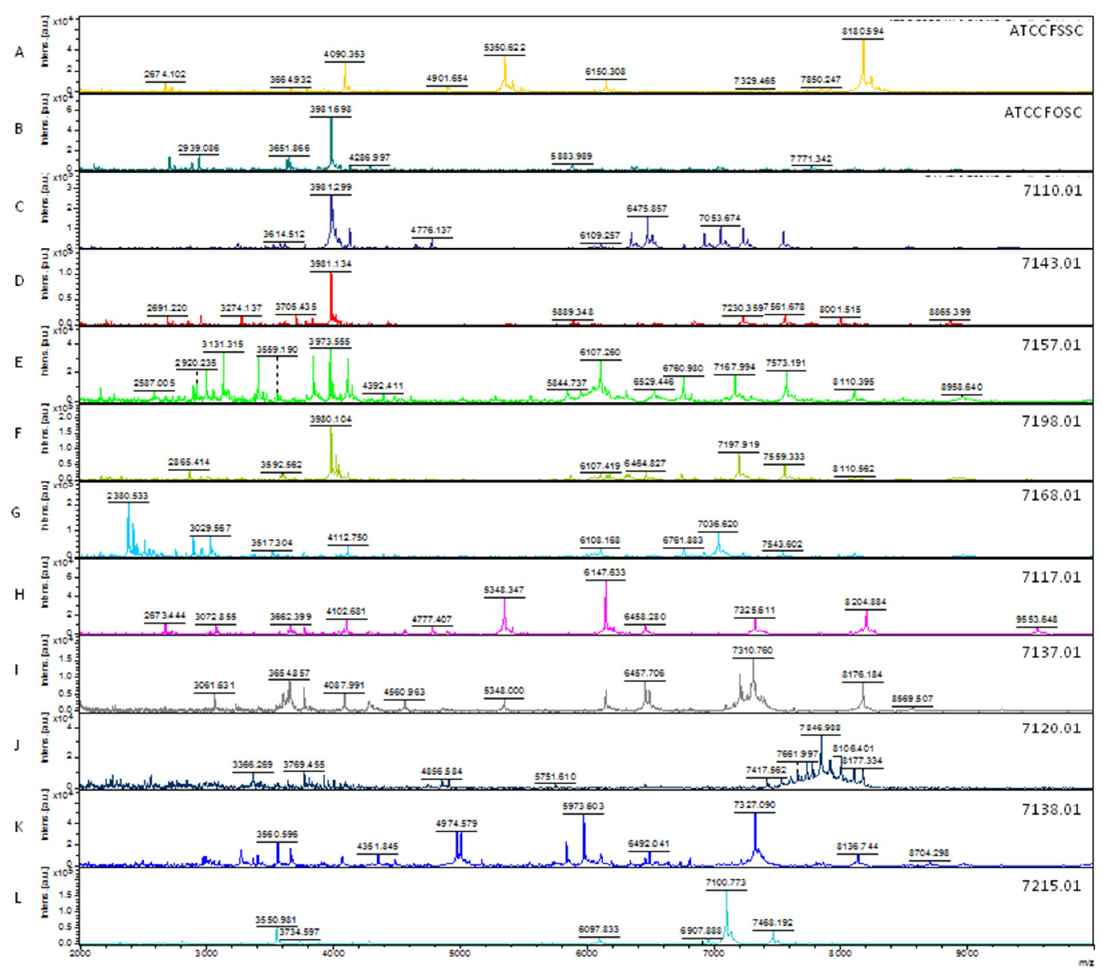
Figure 3. Main MALDI-TOF mass spectra profiles for Fusarium species complexes. ( A) FSSC strain spectrum (F. keratoplasticum— ATCC 36031) ; ( B ) FOSC strain spectrum ( F. oxysporum —ATCC 48112);